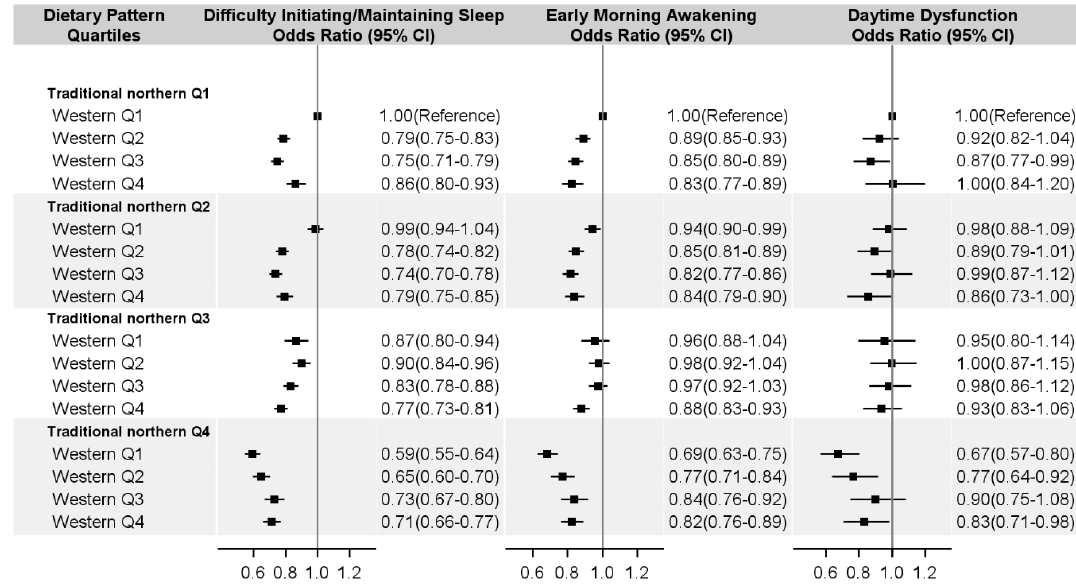
Figure 1. Odds ratio and 95% confidence interval of sleep problems according to the joint classification of dietary patterns. Note: Multivariable-adjusted odds ratio estimated from logistic models adjusted for study site, age (year), gender, BMI (kg/m 2 ), married (yes or no), manual work (yes or no),